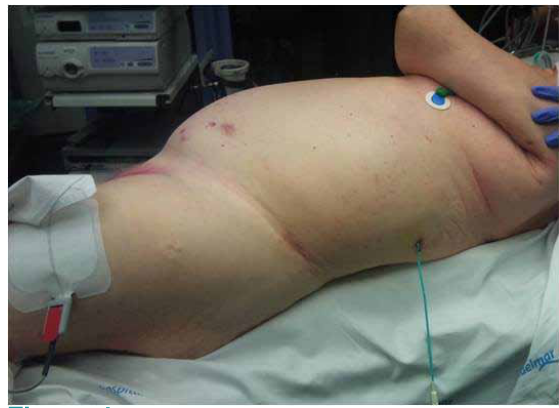
Figure 1. A retroperitoneal percutaneous drain has been inserted under radiologic control in our institution. The catheter will be used as a guide for entering into the pancreatic cell in the strategy of the step-up approach using the VARD